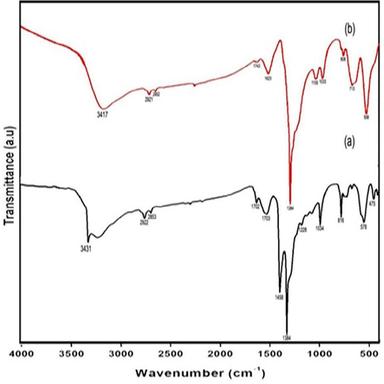
FTR Spectra of synthezied Bi2Se3 nanostrucutes – a) Coprecipitation – with capping b) Hydro thermal with capping.